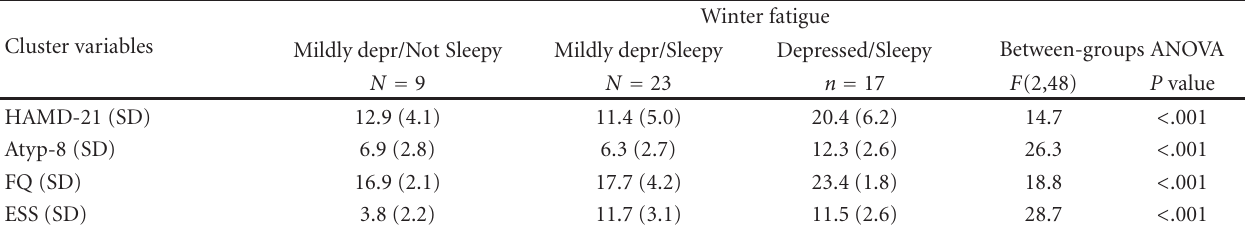
Table 2: Mean values (SD) for the cluster variables in the three clusters at baseline ( N = 49). Cluster